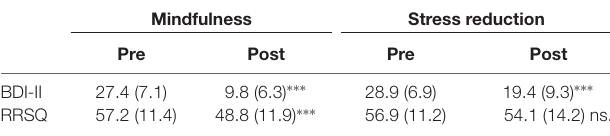
TABLE 2 | Means and standard deviations of depression and rumination scores at pre- and post-assessment in the mindfulness ( n = 36) and stress reduction groups ( n = 29).